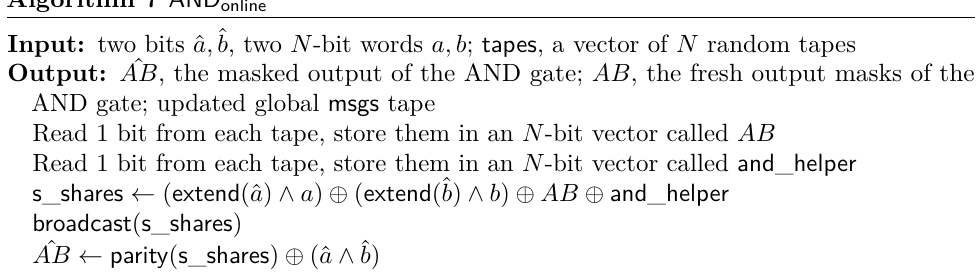
Algorithm 7 AND